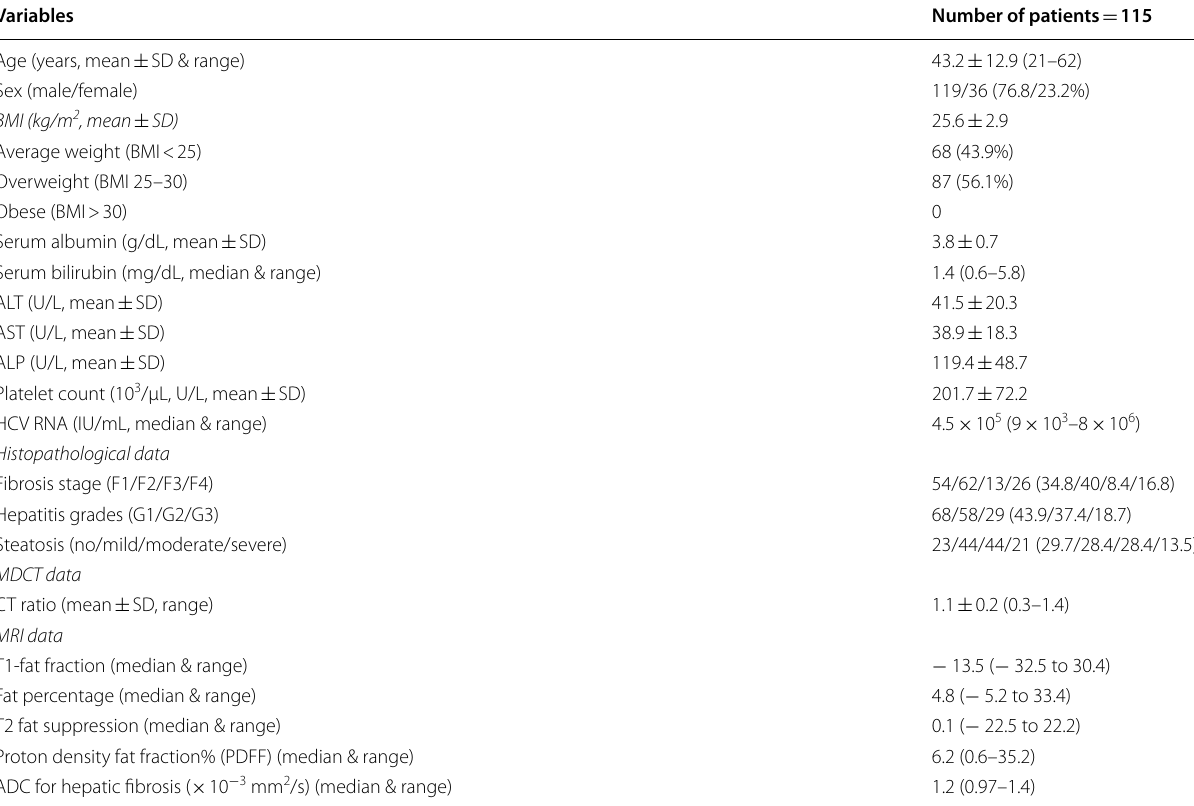
Table 1 Demographic and clinical characteristics of the study patients with genotype-4 chronic hepatitis